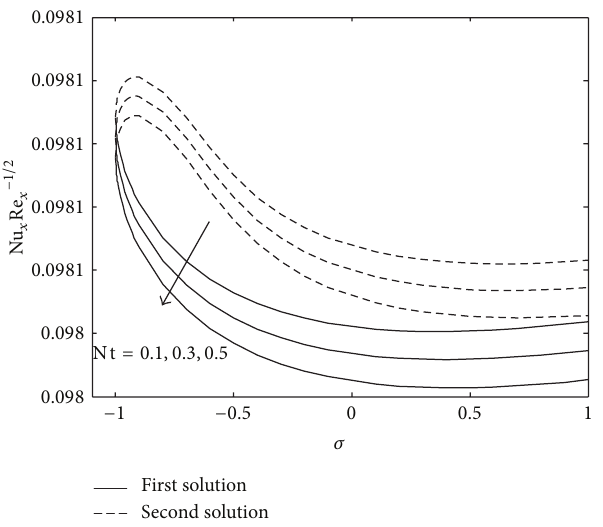
Figure 5: Variations of the local Sherwood number (concentration rates) with 𝜎 for different values of 𝛾 when Nb = Nt = 0.5, Le = 2, Pr = 6.8, and S =